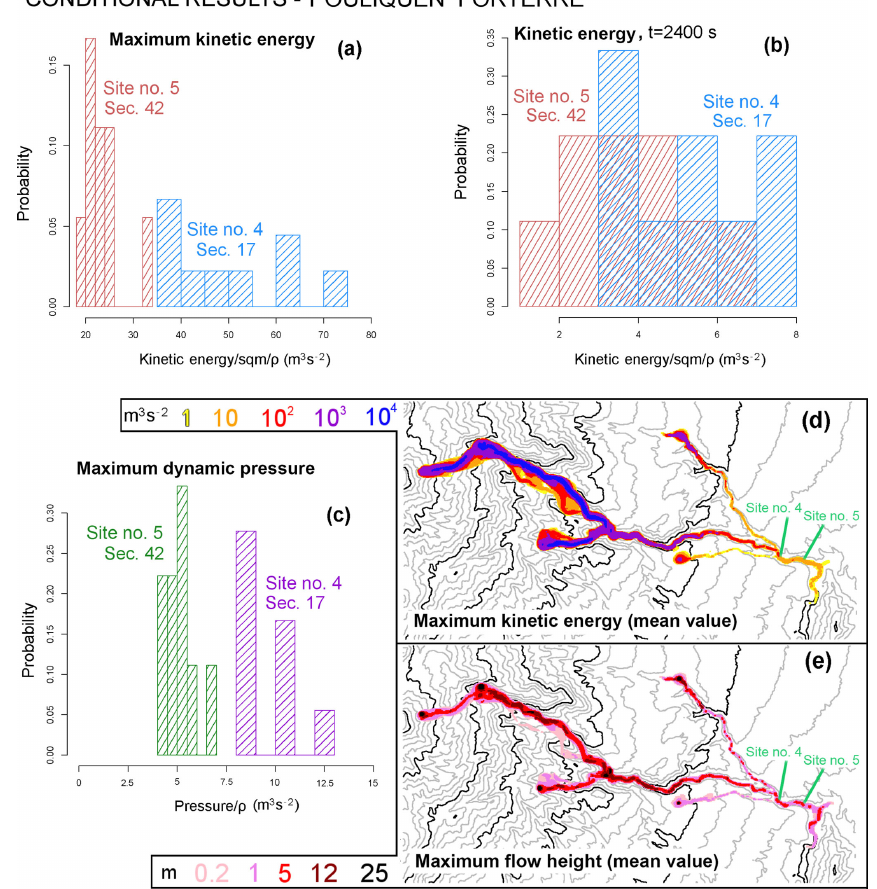
Figure 18. Flow properties of PF model, over the input space e (cid:50) PF . Histograms of (a, b) local kinetic energy and (c) dynamic pressure at 3 sites 4 and 5, (a) at t = 2400s and with (b, c) maximum value. Different sites are displayed with different colors. Mean values over e (cid:50) PF the maps of maximum (d) kinetic energy and (e) flow height as a function of time. Colors are related to their values. Elevation contours are included at intervals of 100m (gray) and 500m (black) (NASA – JPL, 2014). Sites 4 and 5 are